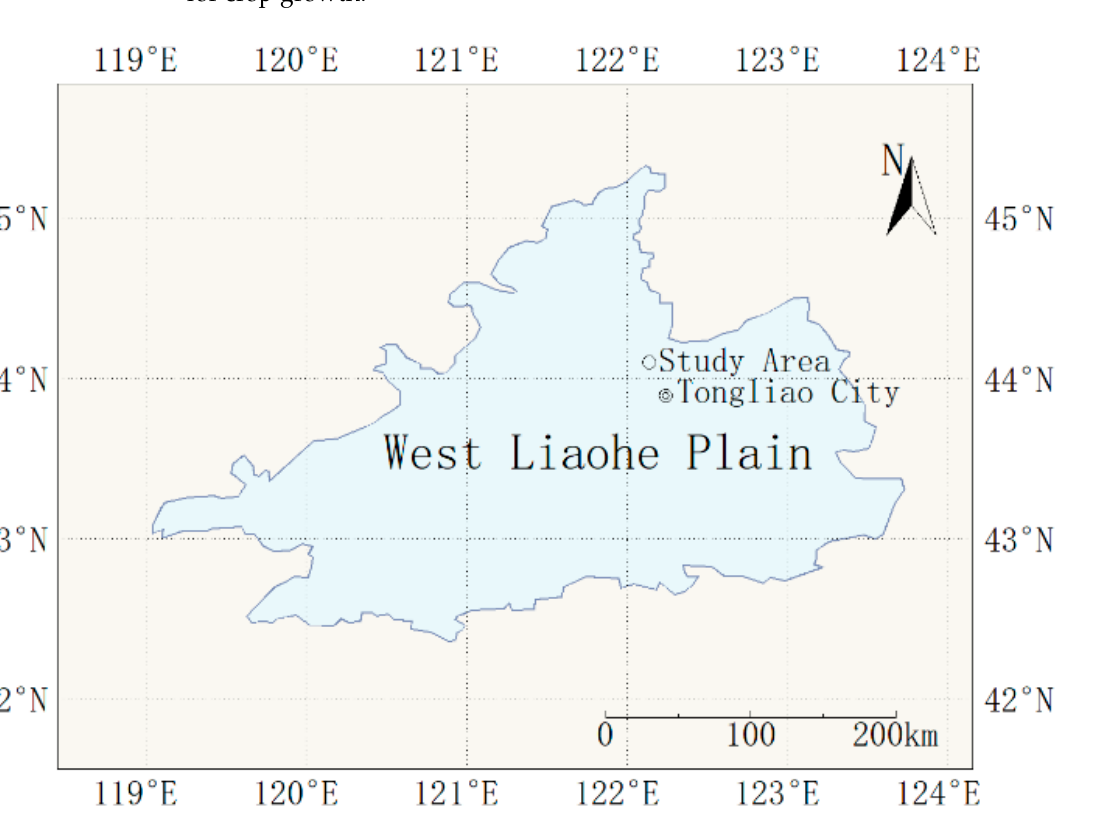
Figure 1. Location of study area.